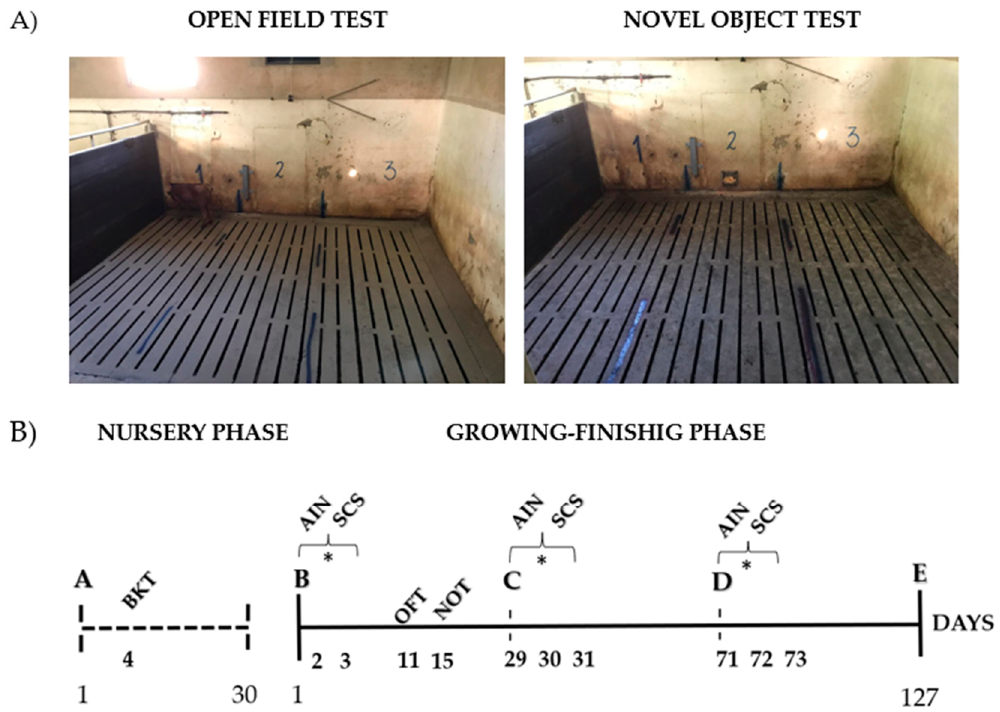
Figure 3 . ( A ) Record of the pen area used for tests and ( B ) the experiment timeline in days, with all